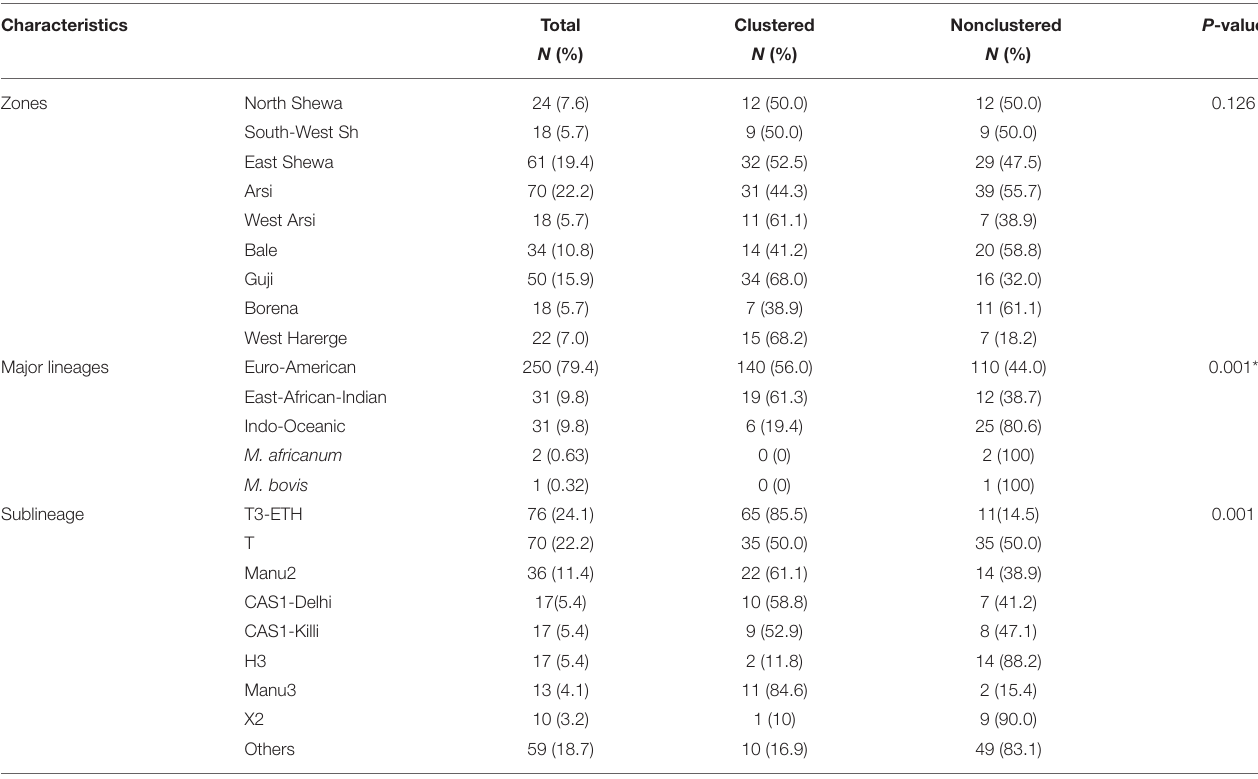
TABLE 3 | Comparison of clustering status within groups of selected variables ( n = 315). Characteristics